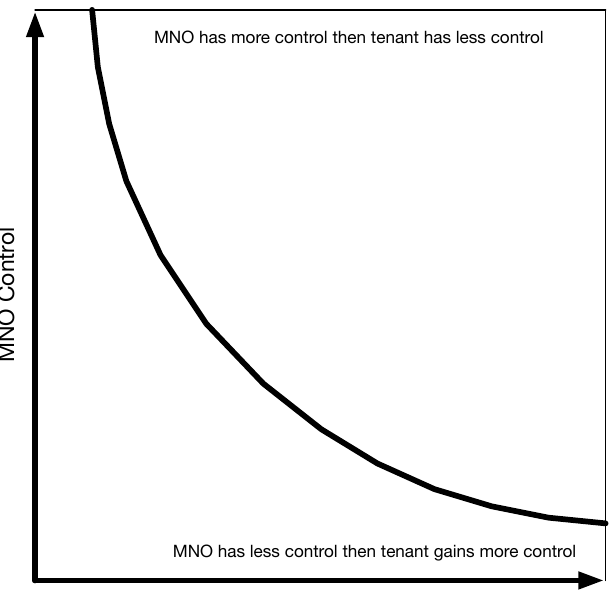
Figure 5. The controls of MNO and tenant are exclusive to each